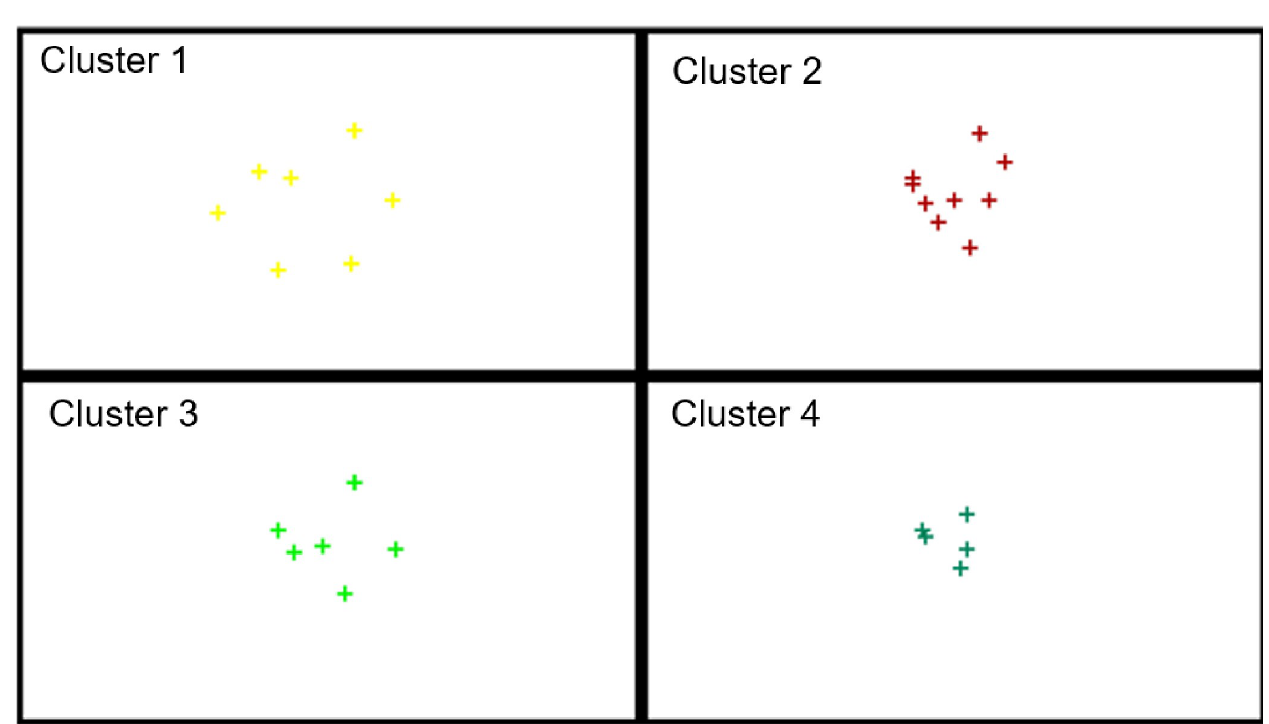
Fig 7. The topological map of similar groups of the EU-27 countries for small